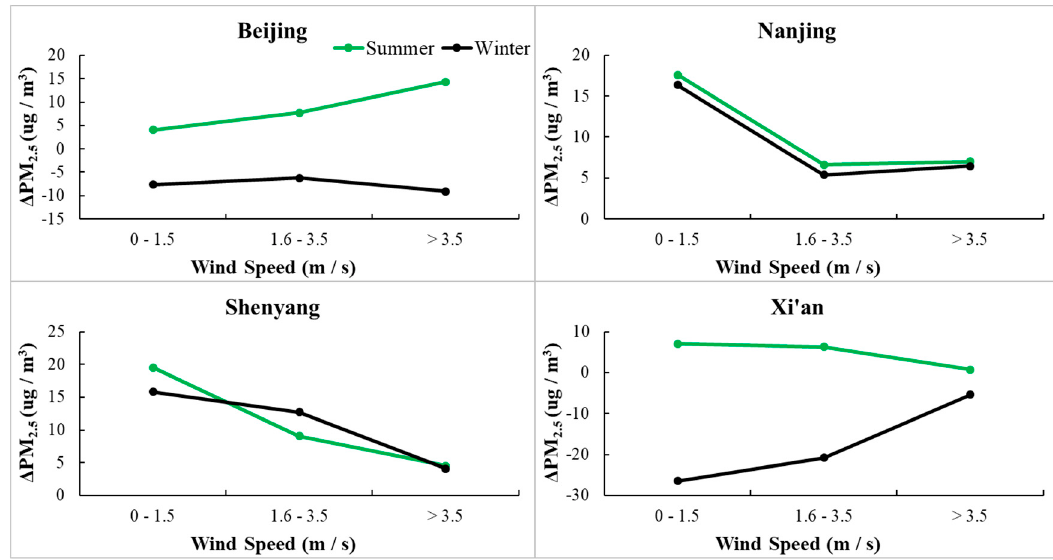
Figure 12. Variations in Δ PM 2.5 concentration (unit: ug / m 3 ) as a function of wind speed in Beijing, Nanjing, Shenyang, and Xi’an in summer (green curves) and winter (black curves). The Δ PM 2.5 concentration is the difference in PM 2.5 concentration between urban and rural areas.